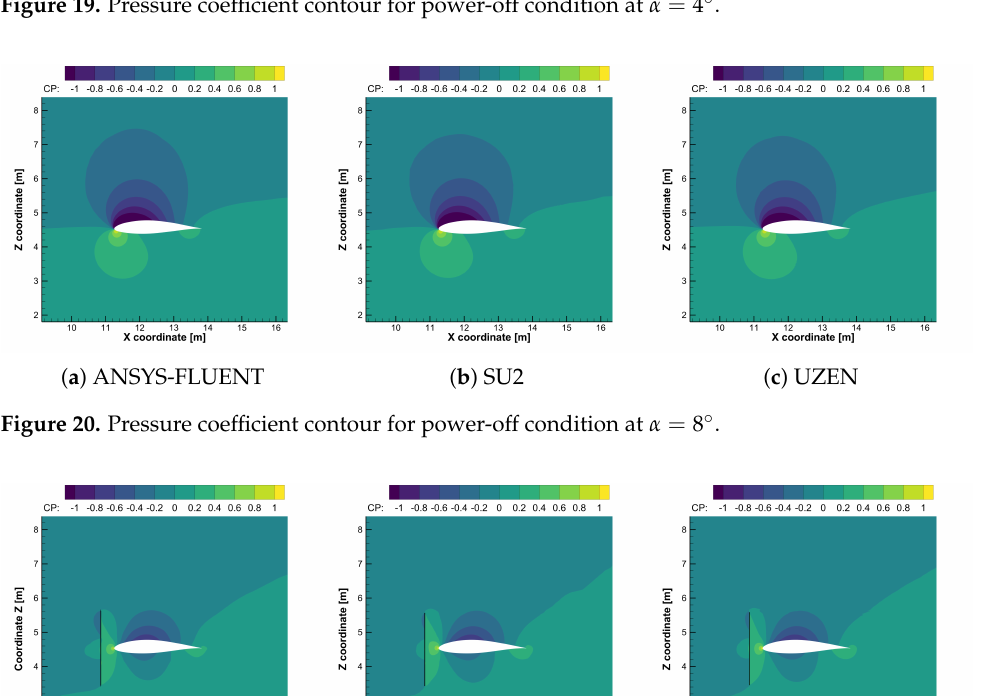
Figure 19. Pressure coefficient contour for power-off condition at α = 4 ◦ .